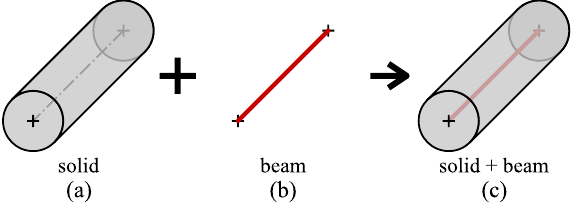
Figure 3. Steel cable modelling: ( a ) Solid elements that account for bending stiffness, ( b ) beam elements that account for tensile stiffness, and ( c ) the combination of solid and beam